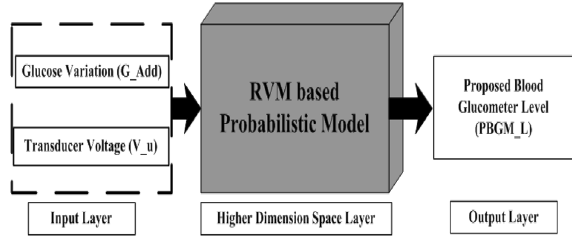
Figure 2. Schematic diagram of the RVM based prediction